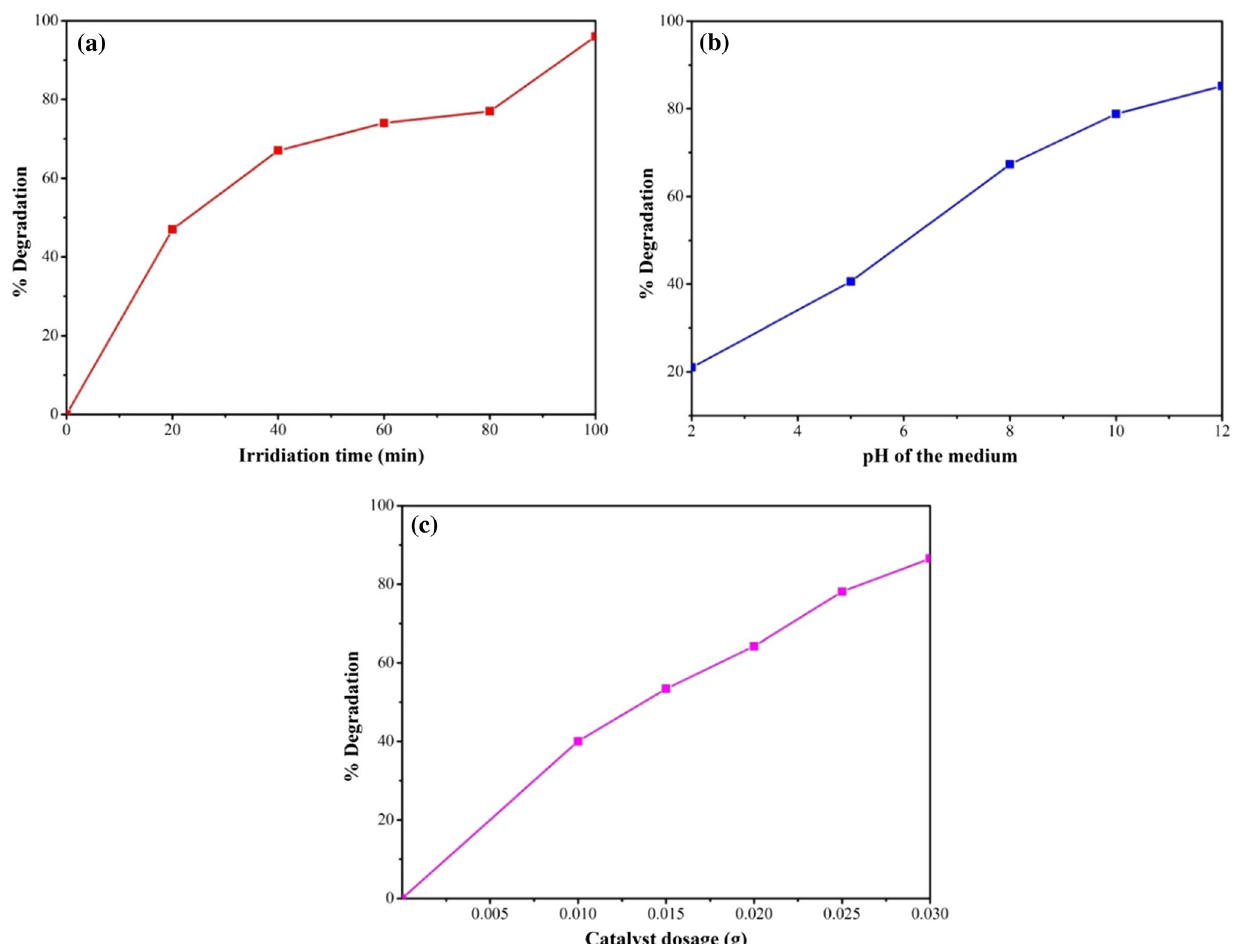
Fig. 10 %degradation of MO dye photodegraded by CdZnTiO photocatalyst